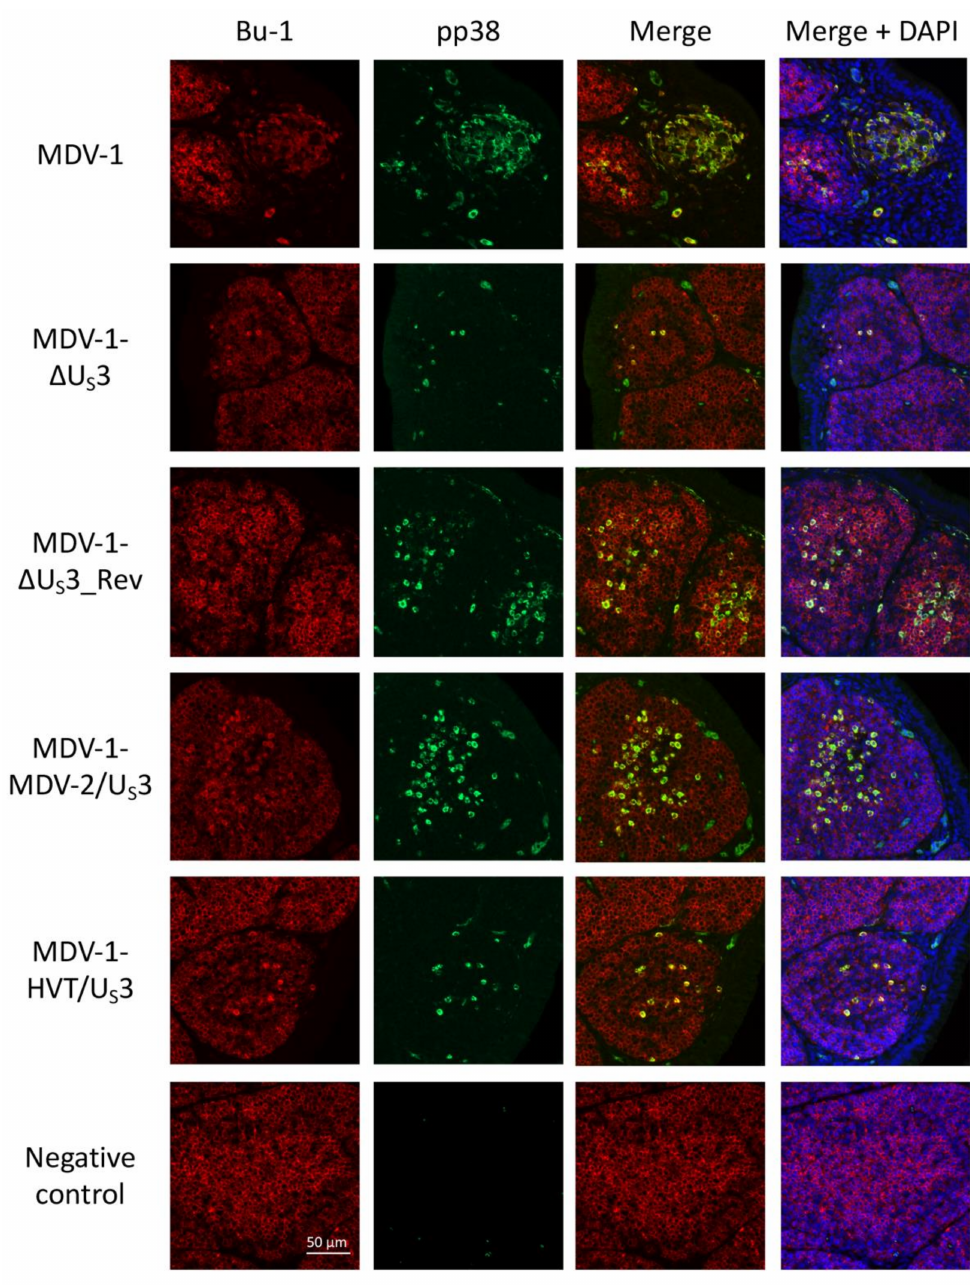
Figure 4. U S 3 of MDV-1, MDV-2, and HVT differentially regulate virus replication in bursal B lymphocytes. Bursa tissue sections, prepared from virus-inoculated or uninoculated (negative control) chickens, were subjected to immunofluorescence assay. After blocking, sections were incubated with mouse anti-pp38 antibody for 1 h at room temperature, followed by another hour incubation with Alexa Flour 488 conjugated goat anti-mouse antibody. After three washes with phosphate-buffered saline (PBS), sections were stained with Alexa Flour 647 conjugated mouse anti-chicken Bu-1 antibody (B lymphocyte marker) for 1 h at room temperature. 4 (cid:48) ,6-diamidino-2-phenylindole (DAPI) was used to stain cell nuclei. A representative image of three independent samples from each group is presented; the scale bar is the same for every panel (scale bar = 50 µ